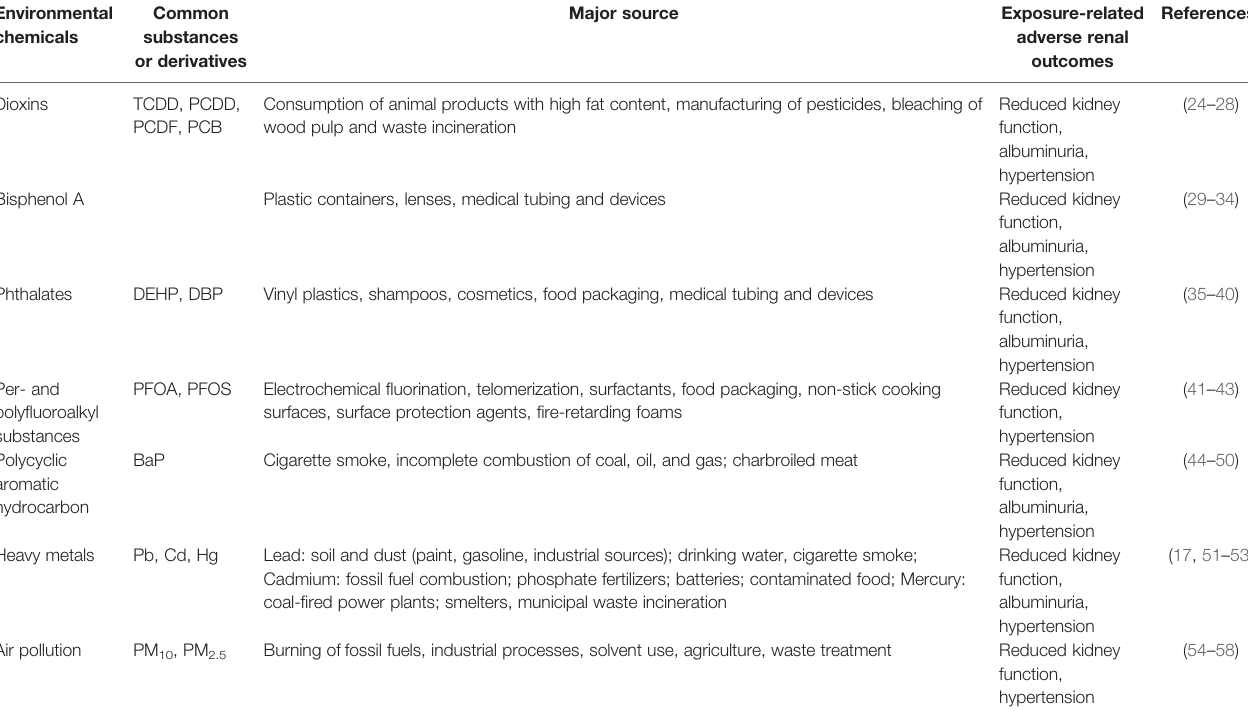
TABLE 1 | Major source and exposure-related adverse renal outcomes of environmental